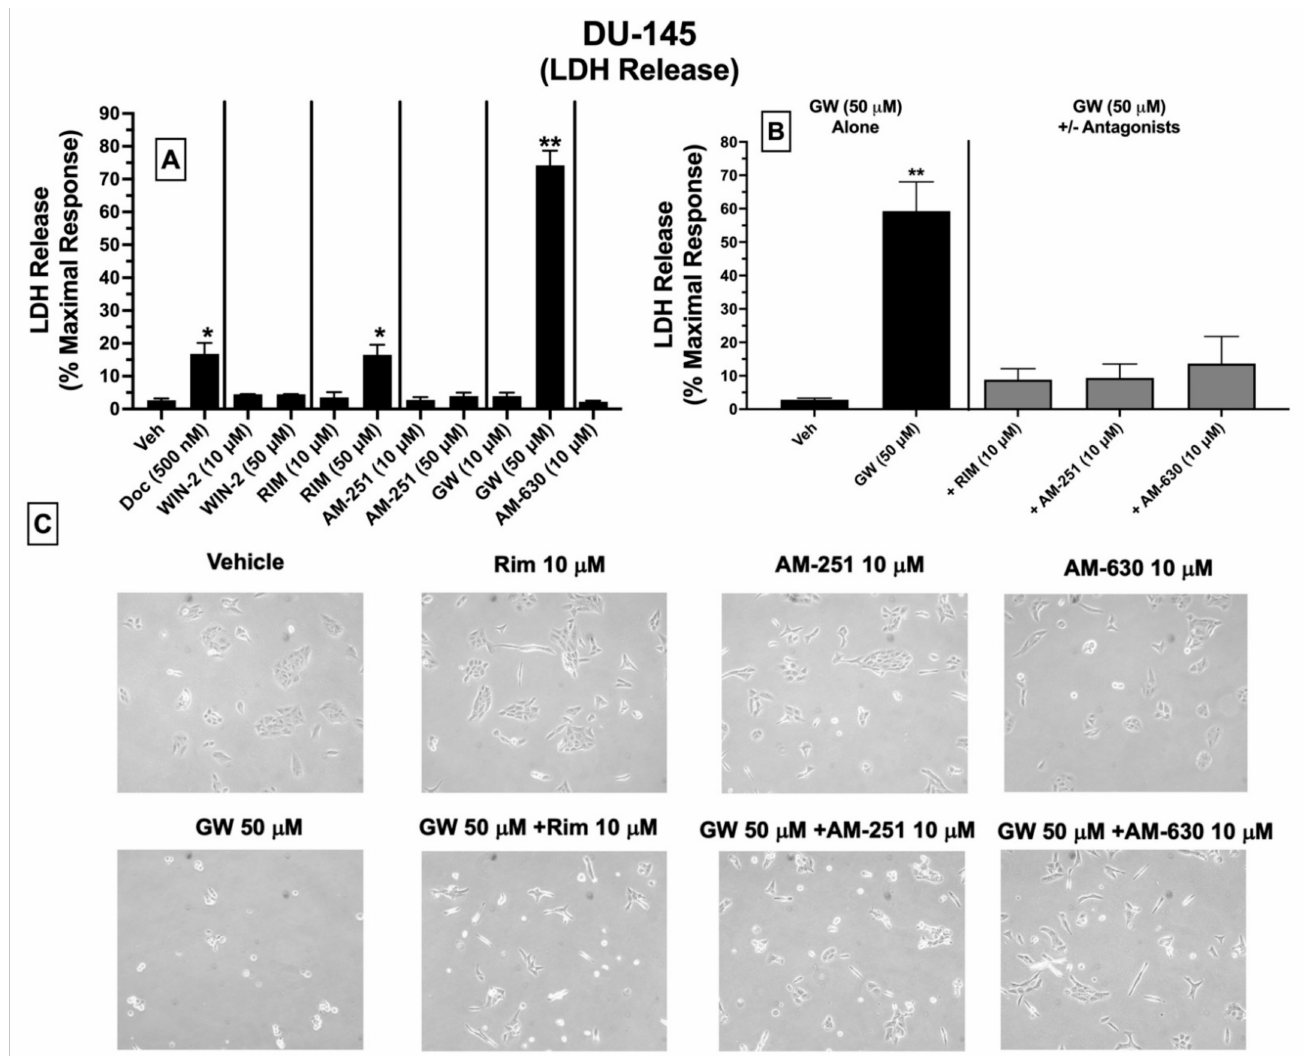
Figure 7. LDH cytotoxicity: DU-145 cells treated with ligands exhibiting high affinity for expressed CBRs induce cell death. Cytotoxicity was determined by assessing LDH release following 24 h incubation of DU-145 cells with CBR ligands. ( A ) LDH release was measured 24 h after treatment of cells with a lower (10 µ M) and higher (50 µ M) concentration of CBR ligands when administered alone. ( B ) To determine whether LDH released by GW-405833 could be antagonized by lower concentrations of CBR ligands producing little or no cytotoxicity when tested alone, LDH release was measured following co-incubation of GW-405833 (50 µ M) with (10 µ M of) each CBR ligand examined. ( C ) Microscopic evaluation for qualitative assessment of protection against GW-405833-induced cytotoxicity. Representative images of DU-145 cells were acquired prior to performing an LDH release assay after cells were subjected to the indicated drug treatment. Data are reported as